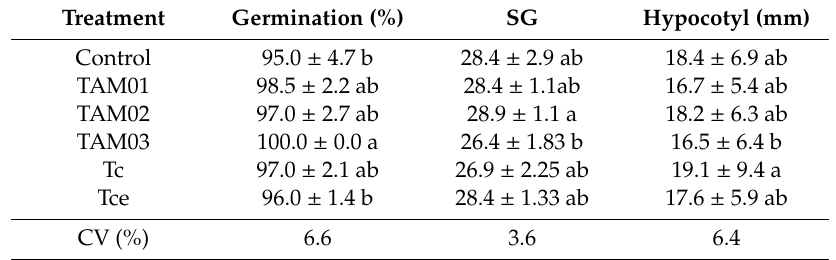
Table 1. Percentage and standard deviation of germination, speed of germination (SG), and hypocotyl length of untreated aça í ( Euterpe oleracea ) seeds treated with di ff erent Trichoderma spp.